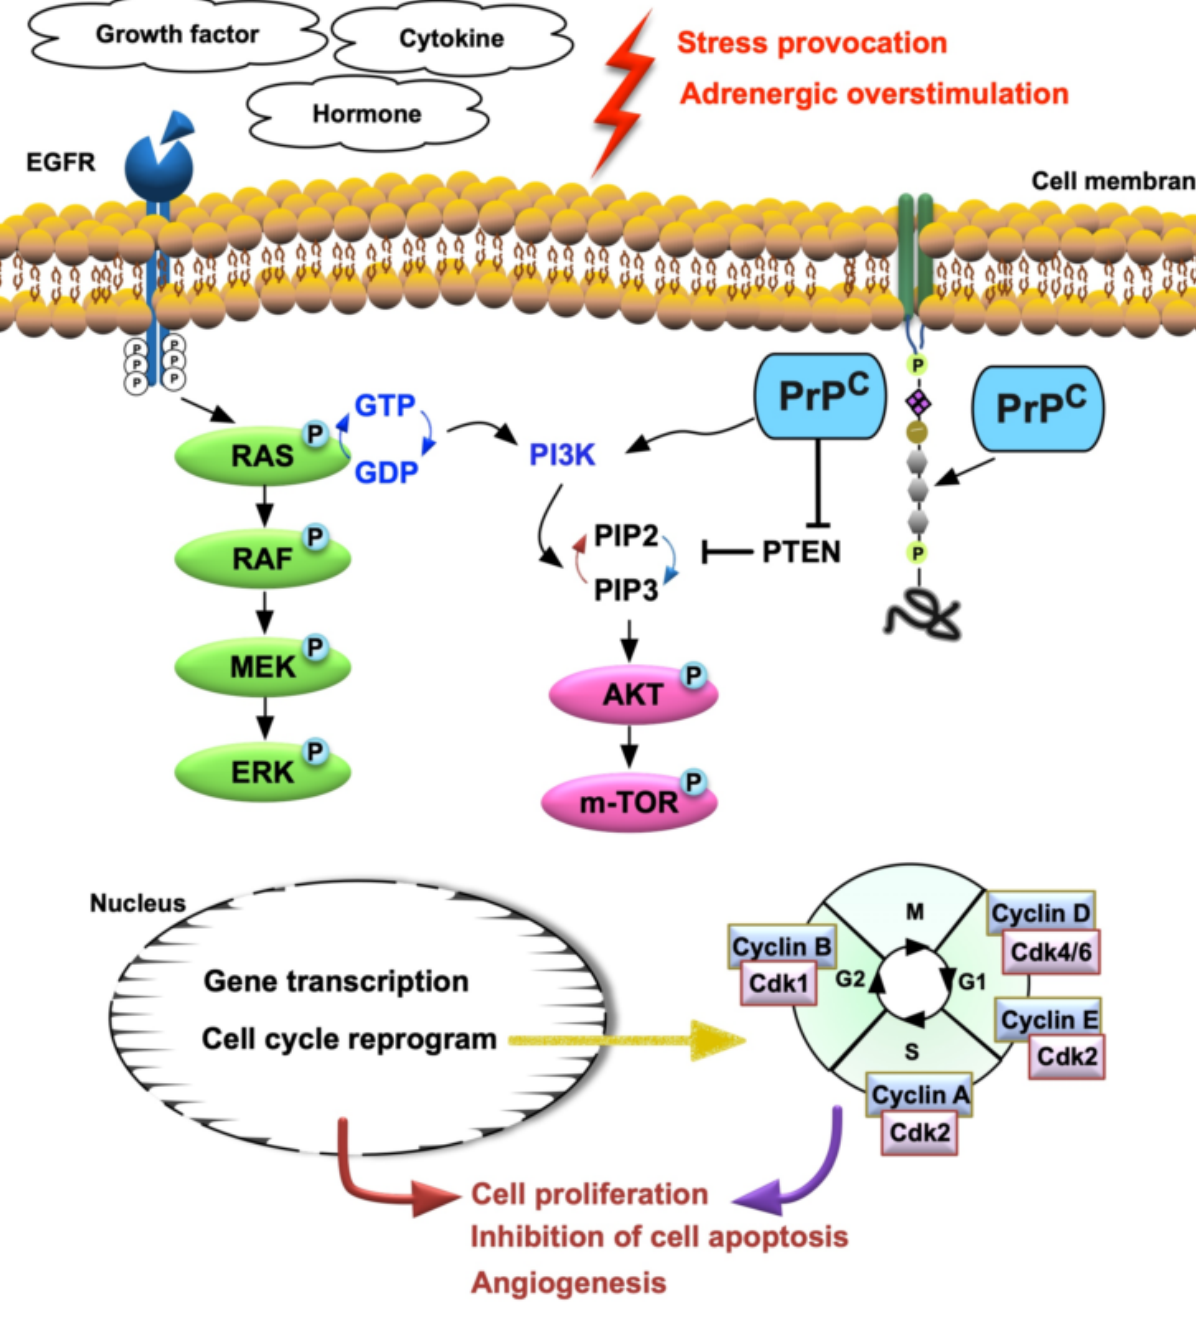
Figure 10. Schematically illustrating the proposed mechanism of PrP C involving the regeneration of myocardial tissues after apical ballooning. PrP C = cellular prion protein; EGFR = epidermic growth factor.